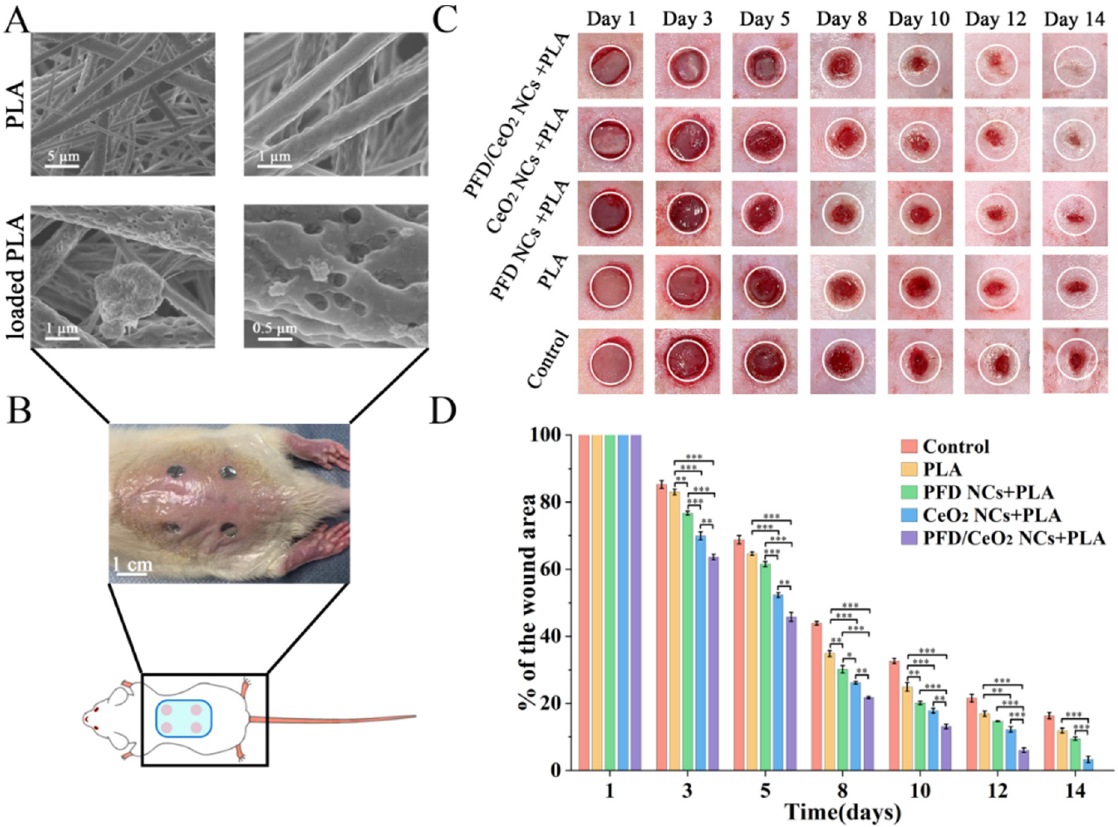
Figure 5. ( A ) SEM of PLA fibers and NC-loaded PLA fibers; ( B ) The schematic of mouse wound-healing model; ( C ) The effect of different dressings on wound closure of full-thickness ex- cisional wounds in mice; representative images wounds of each group during 14 days; ( D ) Per- centage of wound area in each group over 14 days.(*, p < 0.05; **, p < 0.001; ***, p <